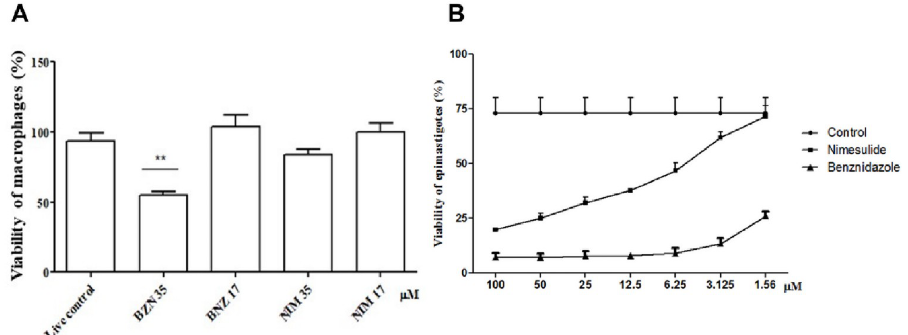
Fig 2. A . Cytotoxicity assay. Peritoneal macrophages of BALB/c mice incubated with benznidazole and nimesulide, at concentrations of 17 and 35 μ M. Representative results from two independent experiments. B . Cell viability of T . cruzi epimastigotes (Y strain) in different concentrations of NIM and BNZ. Treatment after 48 hours of incubation at 27˚C. In this assay, the inhibitory concentration (IC 50 ) of nimesulide against epimastigotes was 12.93 ± 0.03 μ M, and for benznidazole 3.82 ± 0.65 μ M. Both results were for two independent experiments. Asterisks represent the significant difference from the untreated control (p < 0.05).